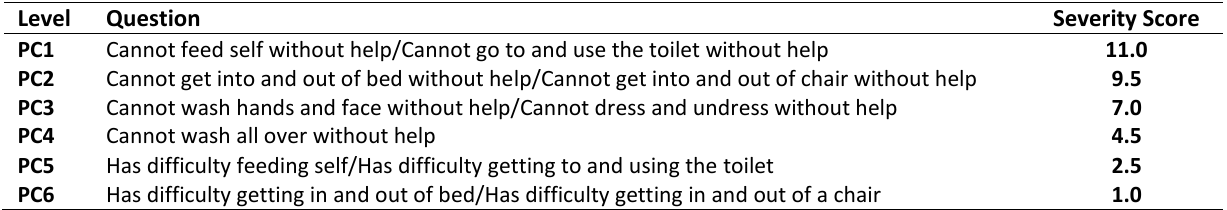
Table 5. Different levels of personal care ability and respective severity scores. Sources: Grundy et al. (1999) and Martin et al. (1988).